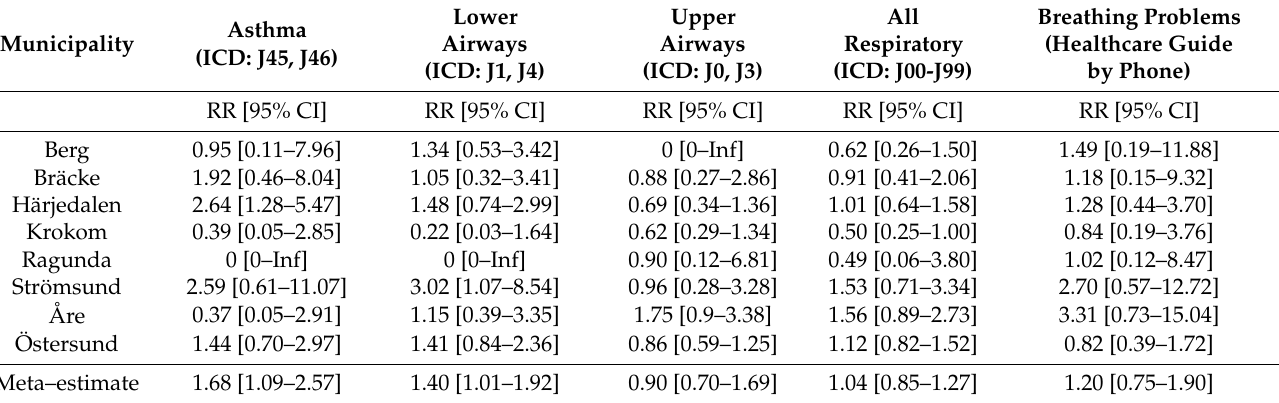
Table 2. Estimated relative risks (RR) and 95% confidence intervals [95% CI] associated with exposure to smoke from wildfires in the individual municipalities and combined into a